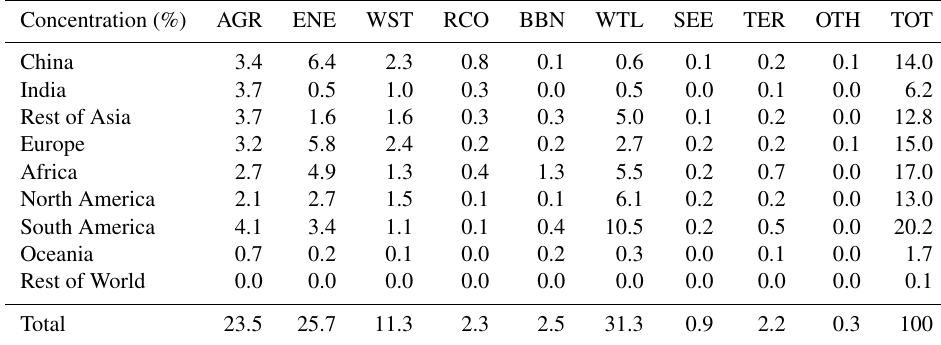
Table 3. Sources contributing to the mean surface CH 4 mixing ratio in China over 2007–2018 ∗ . Concentration (%) AGR ENE WST RCO BBN WTL